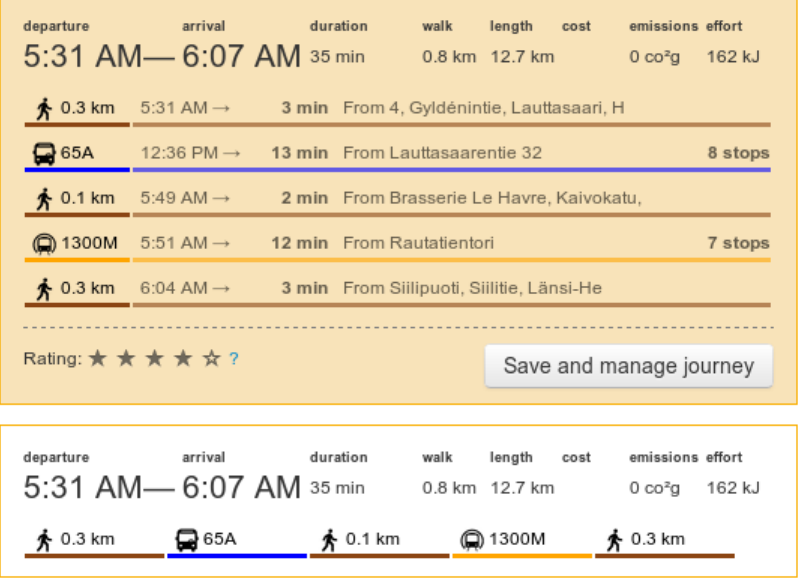
Figure 1. Example output from the multi-modal journey planner indicating the various parameters that are calculated for each journey and which are subsequenty utilised by the challenge